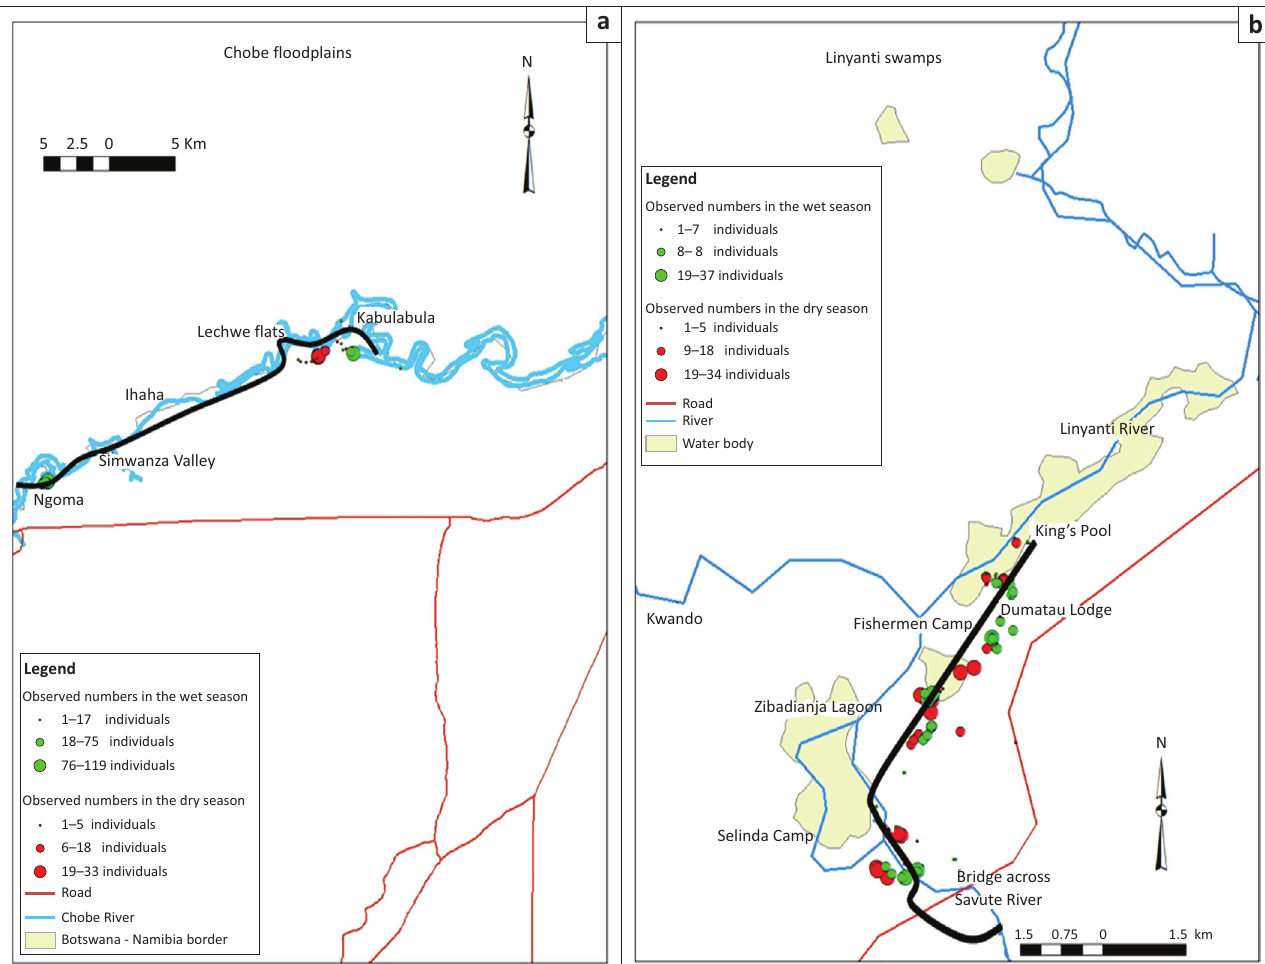
FIGURE 3: Transect layout (black bold line) and observations of red lechwe made along the (a) the Chobe floodplains and (b) the Linyanti